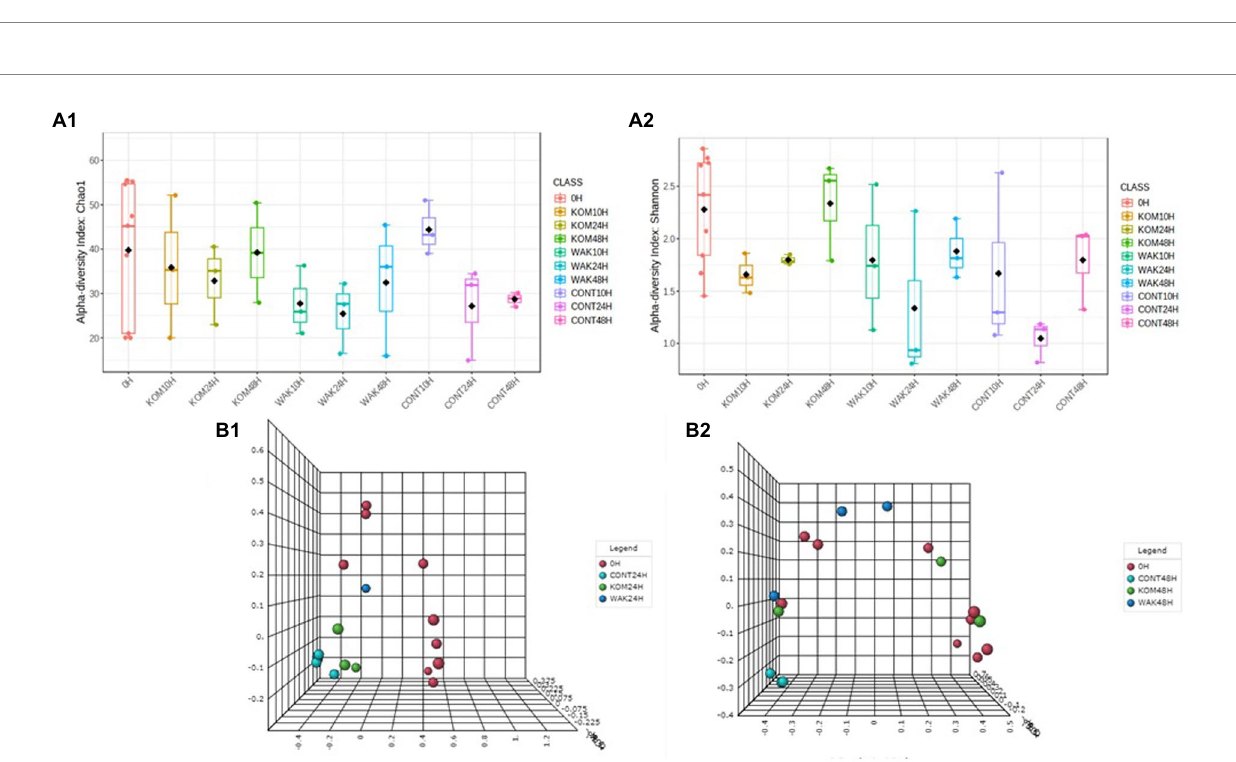
FIGURE 3 Statistical differences for the more abundant identified bacterial species in S. japonica -added samples at 24 h (A) and U. pinnatifida -added samples at 10 h (B) of fermentation with respect to baseline. KOM ( S. japonica , kombu); WAK ( U. pinnatifida , wakame). *Indicates significant